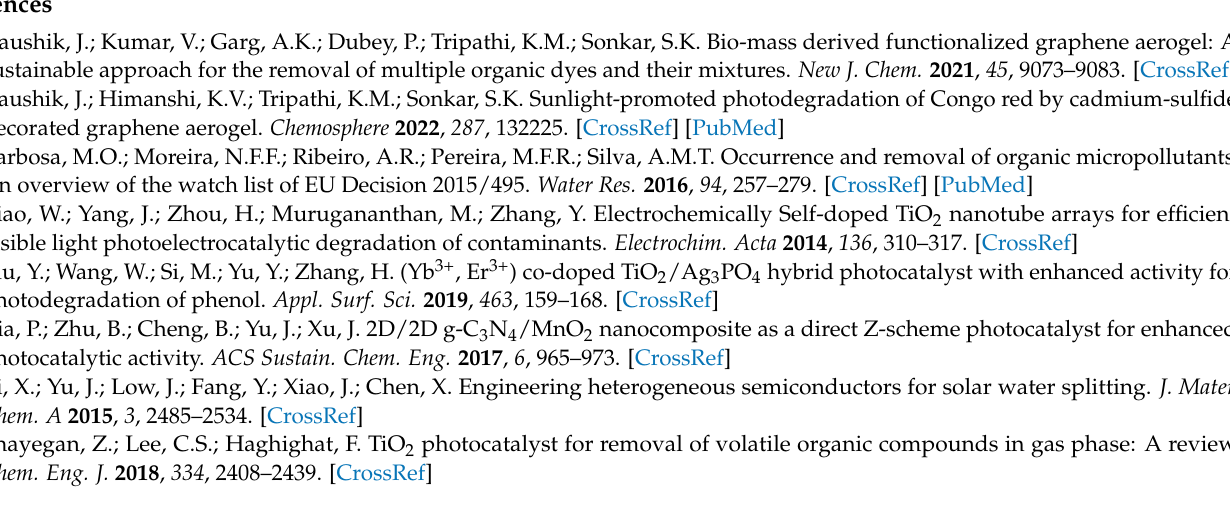
existence of scavengers, Figure S5: The Q total and Q blank of PFC process, Table S1: The kinetic equation of TiO 2 and 1–5% Bi-TiO 2